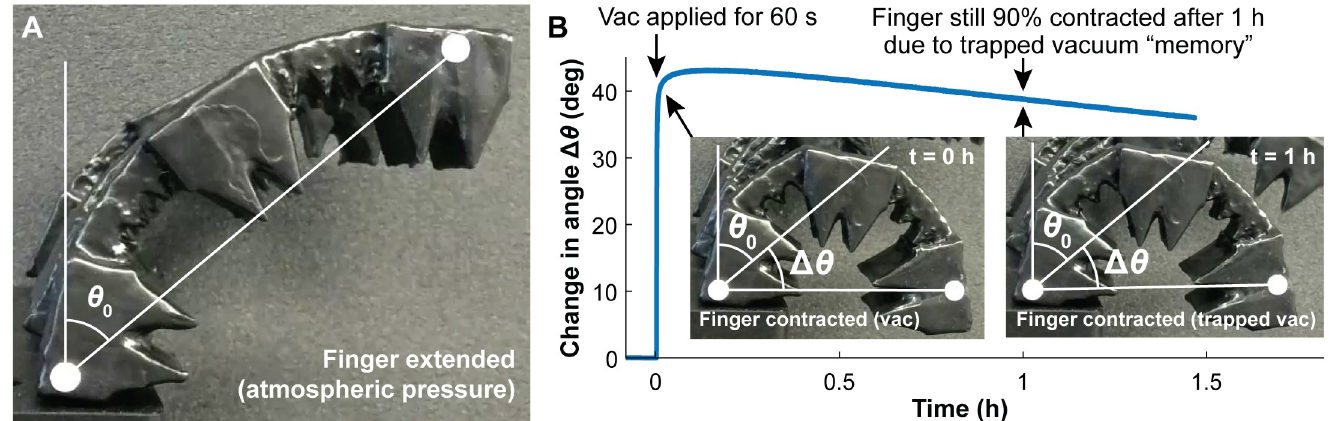
Fig 9. Measuring the amount of time that the pneumatic RAM can “remember” the value of a Memory bit (and how long a soft robotic finger connected to the Memory bit can maintain its actuation state). (A) At atmospheric pressure, the finger has a natural curve with an angle θ 0 . (B) At time = 0, the pneumatic RAM applies vacuum from the Data input to the Memory bit and the finger for an excessively-long 60 s, which causes the finger to contract an additional Δ θ degrees. After 60 s the pneumatic RAM disconnects the Data vacuum from the Memory bit, but the finger remains contracted due to the vacuum trapped in the Memory bit and inside the finger. For the next hour, the pneumatic RAM cycled through three other fingers, contracting and extending one every ten seconds. Even though the pneumatic RAM chip’s operation introduces small amounts of atmospheric-pressure air to the first finger, the finger nonetheless remained 90% contracted 1 h after the applied vacuum was removed. Therefore, a trapped vacuum at a pneumatic RAM Memory bit can hold a finger contracted for at least an hour before needing to be “refreshed” by the pneumatic RAM. A closeup view of the first few seconds of this plot is available as online Supplementary Information .